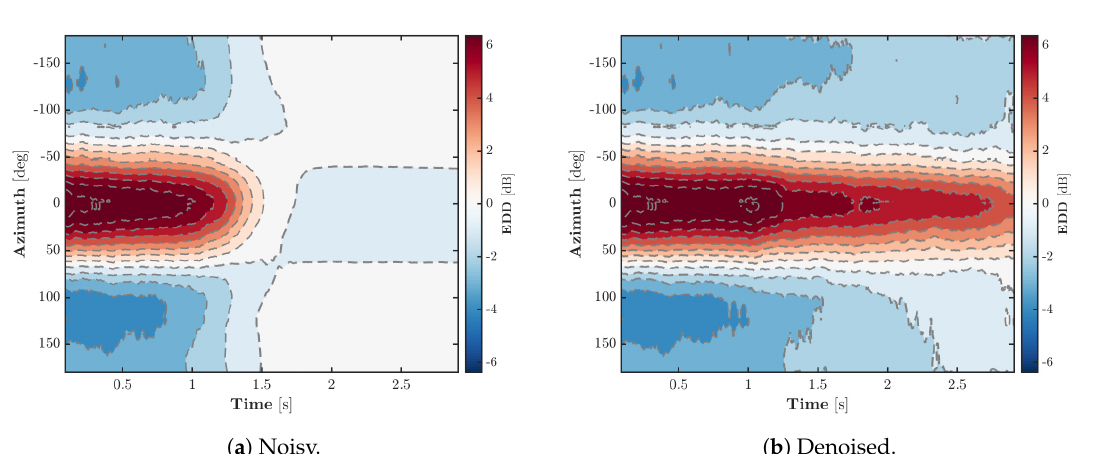
Figure 9. EDDs for ( a ) the noisy DRIR measured in the neo-Gothic chapel at the Dominicans of Haute-Alsace cultural centre and ( b ) the result obtained after application of the proposed denoising process. EDDs once again projected onto the azimuthal plane by cubic Hermite spherical